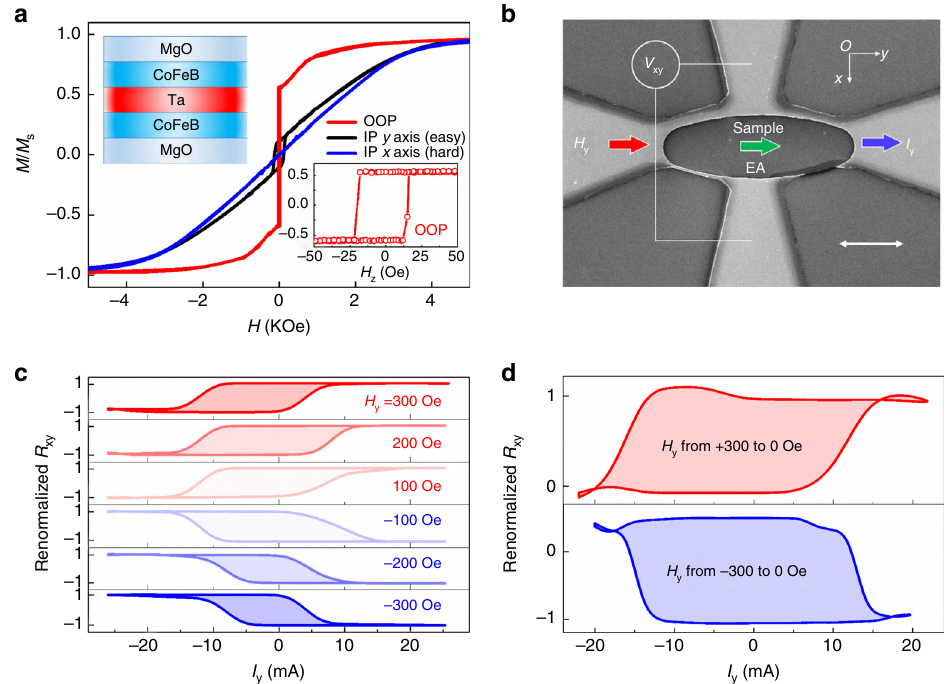
Fig. 2 Field-free switching in Type-z mode. a M – H hysteresis of the raw fi lm. b Structure of a patterned fi lm. Scale bar: 10 μ m. c Field assistance magnetization switching driven by current ( I y ). d Field-free switching of the Hall bar. Renormalized R xy ≡ ( R xy − R 0 )/ Δ R xy max . R xy = V x / I y , R 0 was the median of the R xy vs. H z curve and Δ R xy max = | R xy ( H z = 0) − R 0 |